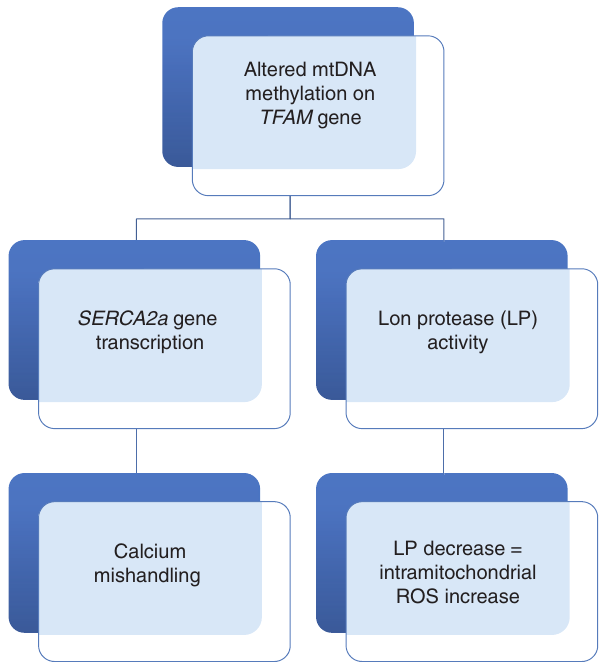
Figure 3: The role of altered mtDNA methylation. mtDNA methylation can shut down certain beneficial genes like Lon protease which can lead to intramitochondrial ROS increase. On the other hand, hypomethylation of TFAM can lead to its increased expression and binding to SERCA2a gene, which subsequently leads to calcium mishandling. All these events together lead to mitochondrial